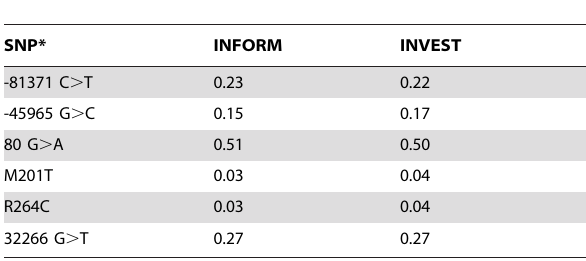
Table 1. Allele Frequencies in INFORM and